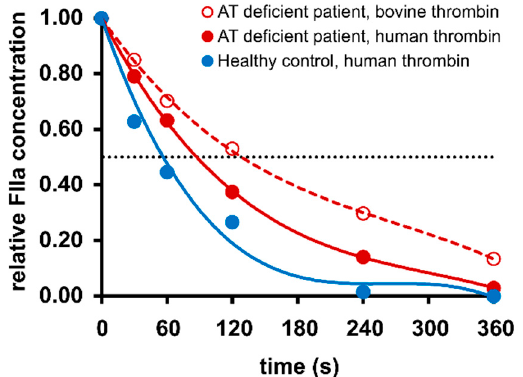
Figure 1. Inactivation kinetics of thrombin in representative human plasma samples. Purified thrombin (FIIa) was added to citrate-anticoagulated plasma obtained from a healthy individual (human thrombin, blue circles) or a patient with hereditary antithrombin (AT) deficiency (human thrombin, red filled circles; bovine thrombin, red unfilled circles) to achieve a final concentration of 2 ng/mL. At the indicated time points, thrombin inactivation was stopped by the addition of argatroban at a final concentration of 200 µ mol/L and the residual thrombin activation measured using the thrombin-oligonucleotide-based enzyme capture